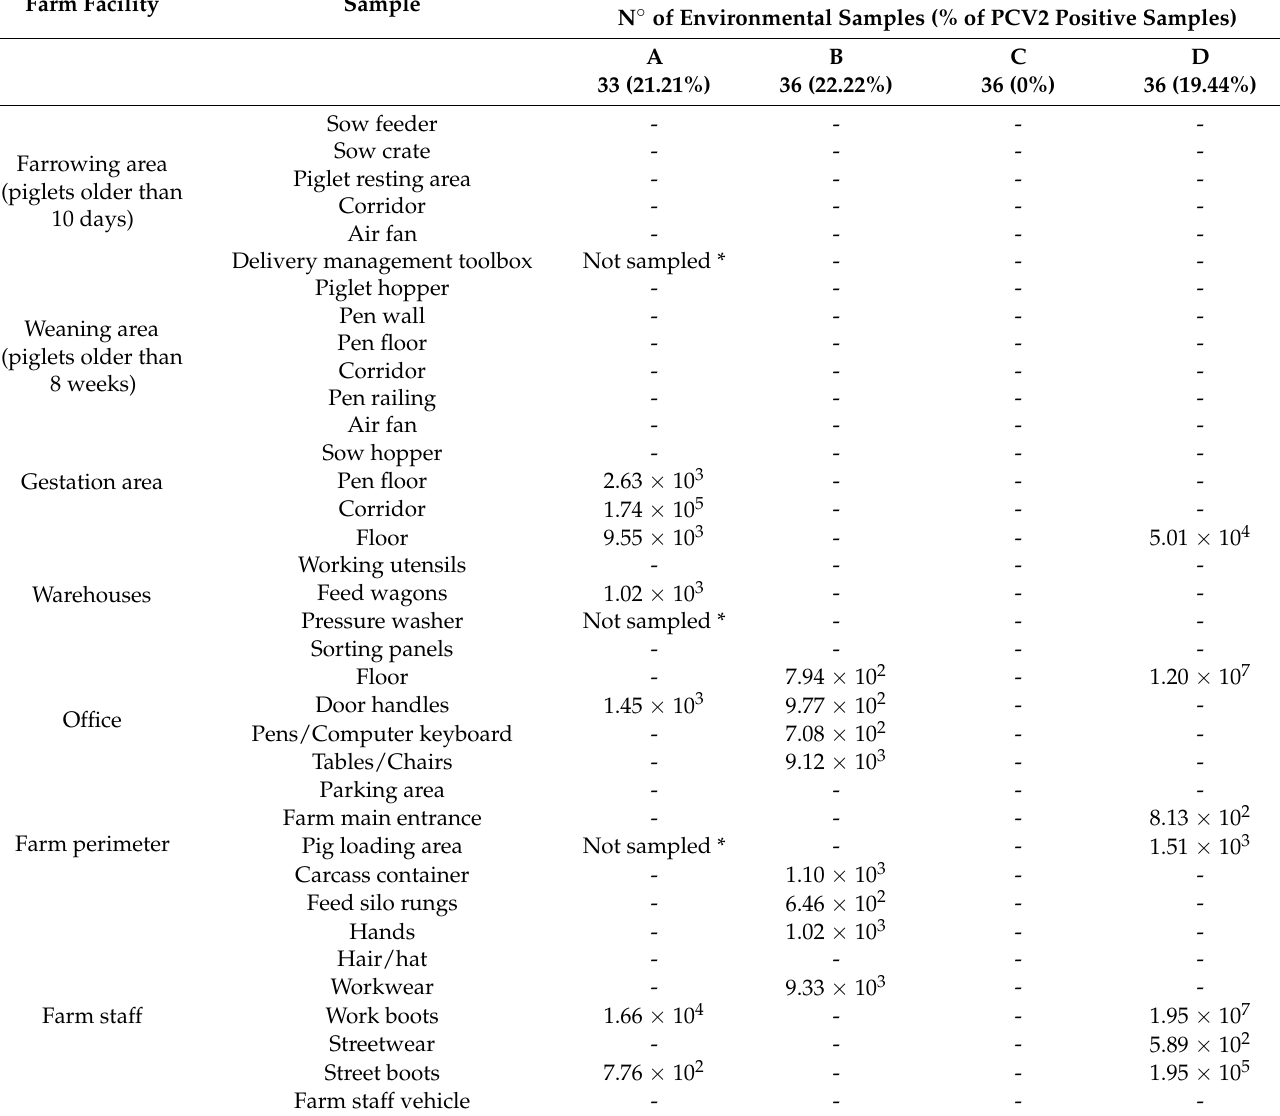
Table 3. Number of PCV2 copies/swabs in each environmental sample in each